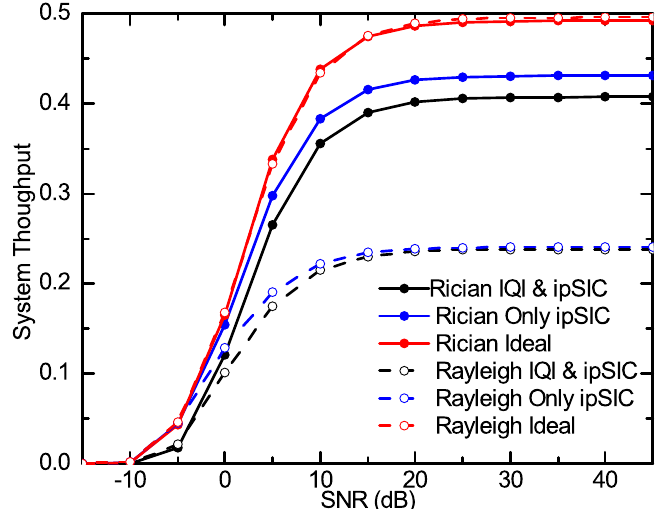
Figure 5. Outage probability versus the amplitude mismatch for the system with ipSIC and pSIC conditions. The effects of the three different conditions for the system throughput are evaluated in Figure 6, in which we fix the parameters of IQI as g t = g r = 0.8, ϕ t = ϕ r = 5 ◦ and the ipSIC parameters as ε = 0.03 for the IQI and ipSIC conditions. For only the ipSIC condition, we fix the parameters of IQI as g t = g r = 1, ϕ t = ϕ r = 0 ◦ and ipSIC parameters as ε = 0.03. For the ideal condition, we use the parameters of IQI as g t = g r = 1, ϕ t = ϕ r = 0 ◦ and ipSIC parameters as ε = 0. In the SNR range from 10dB to 45dB, the analysis curves of the system throughput with IQI and/or ipSIC condition is − always lower than that of the ideal condition. It should be noted that the system throughput enhances as the SNR increase. Moreover, both system throughputs gradually tend to be stable in high SNR region. It can be observed from Figure 6 that the system throughput under two channels is the same in the low SNR region, and at high SNRs, the Rayleigh fading is slightly better than the throughput of the Rician fading channels in the ideal condition. However, in other non-ideal conditions, it is obviously worse than Rician fading channels. Therefore, a conclusion can be obtained that there is almost no difference of the considered system throughput with the ideal condition in the two channel cases, and IQI and ipSIC have worse effects on the system throughput with Rayleigh fading channels than on Rician.